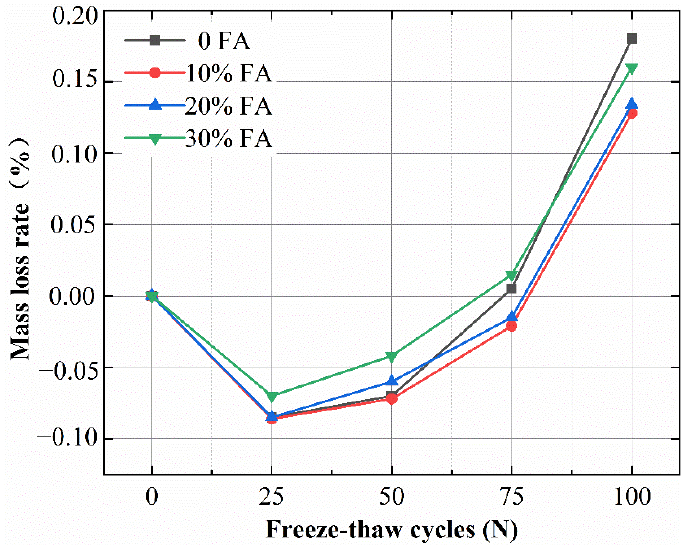
Figure 4. Mass loss rate of concrete specimens.